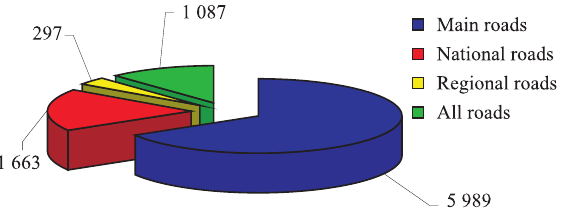
Fig. 3. Th e AADT of passenger cars in the diff erent group of roads (Accumulation and renewal of traffi c data of the roads of national signifi cance, 2008)